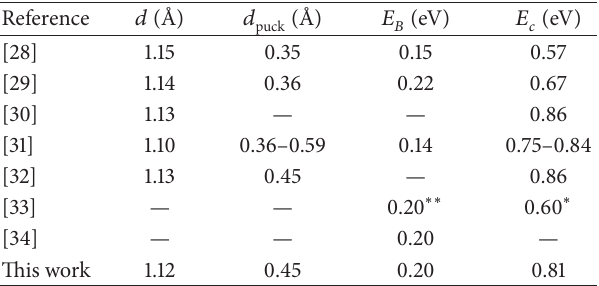
), the energy barrier puck